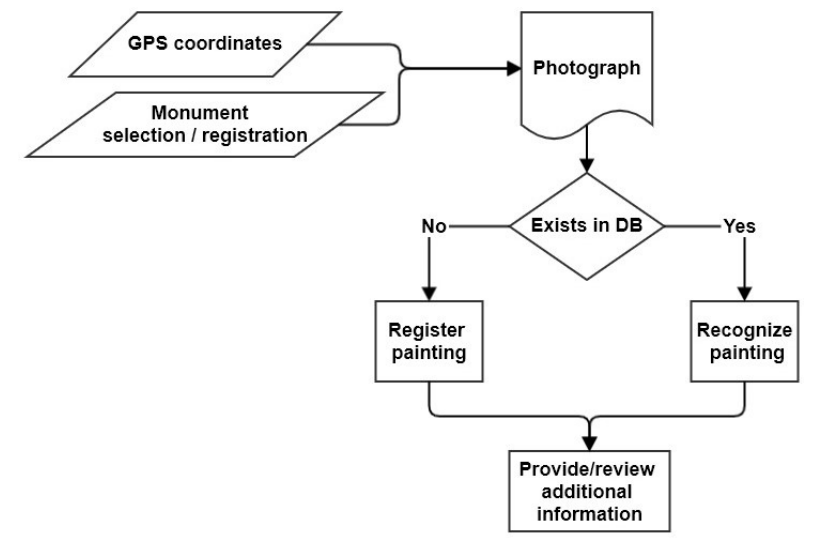
Figure 12. Partial mapping